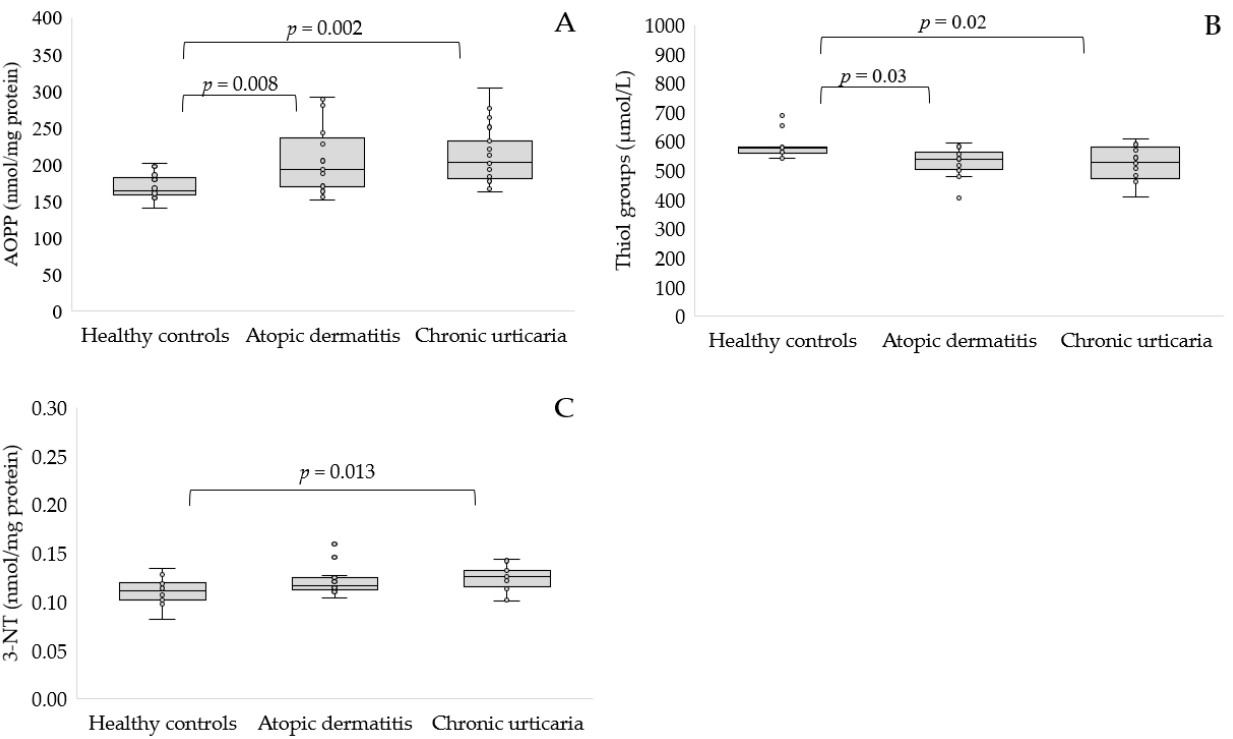
Figure 1. Concentration of AOPP ( A ), thiol groups ( B ) and 3-nitrotyrosine ( C ) in serum of